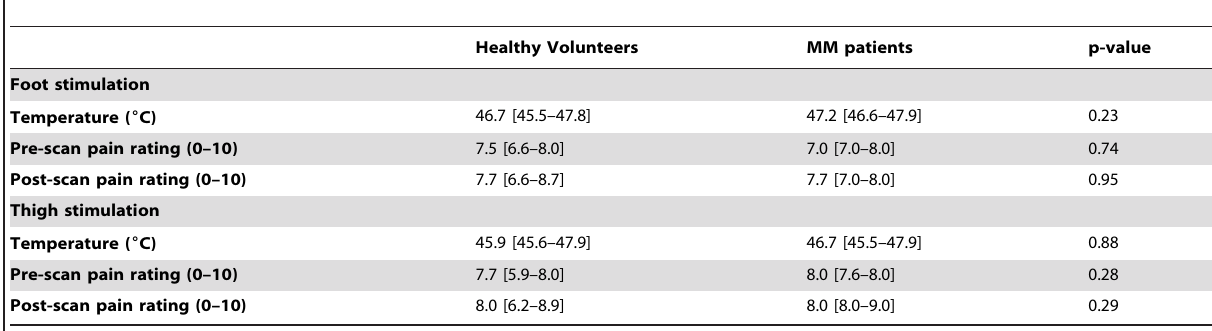
Table 2. Group median [IQR] temperature for pain stimulation and pain